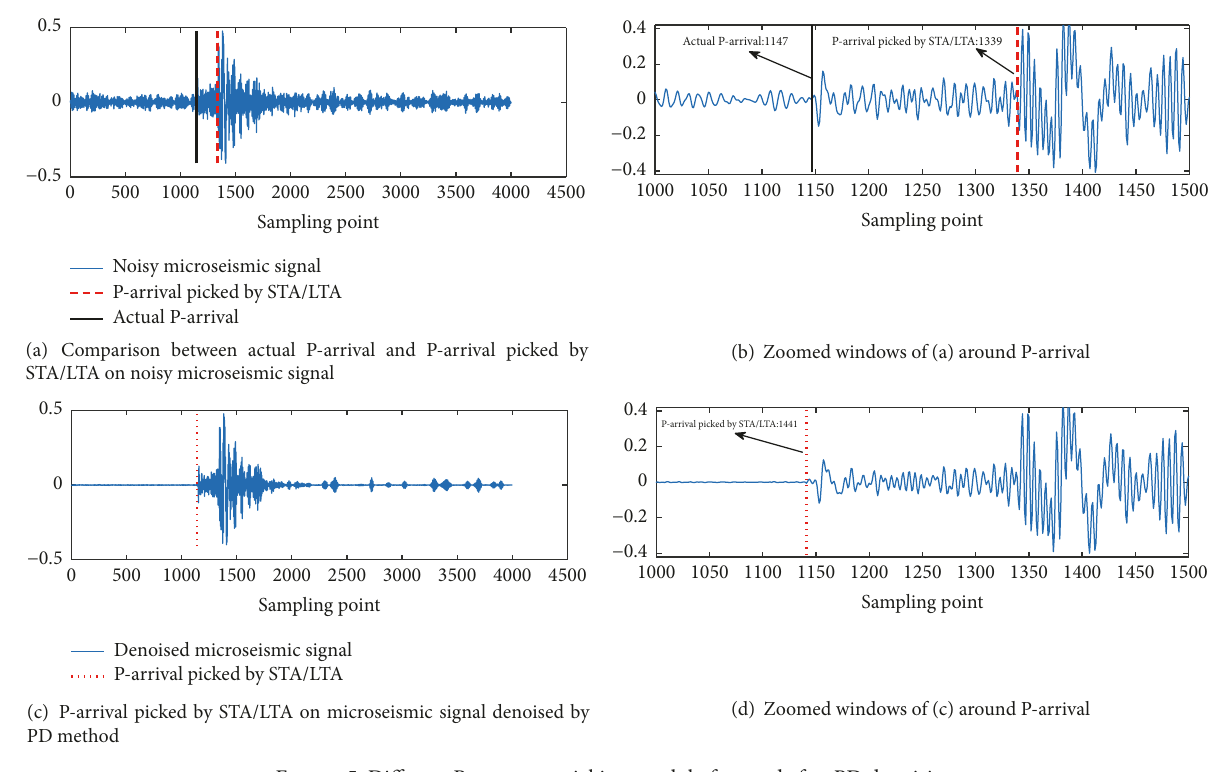
Figure 5: Different P-wave autopicking result before and after PD denoising.